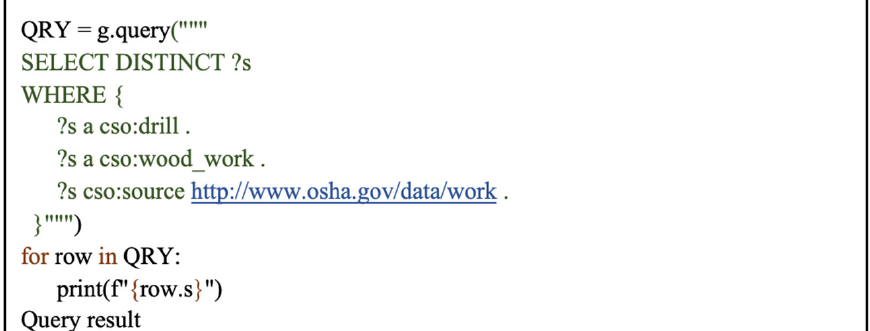
Figure 10. Query 3 code, result, and example of retrieved case.